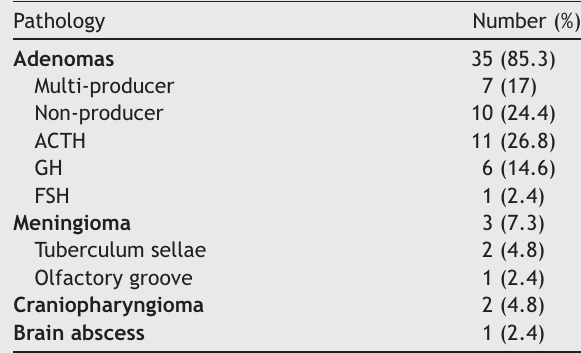
Cases of endonasal endoscopic surgery of the skull base.